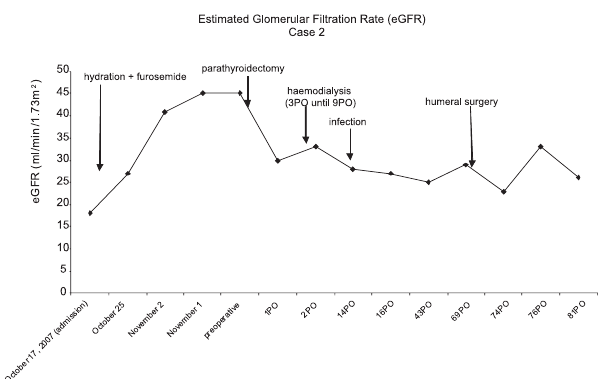
Figure 2 - Estimated glomerular filtration rate before and after parathyroi- dectomy of the second